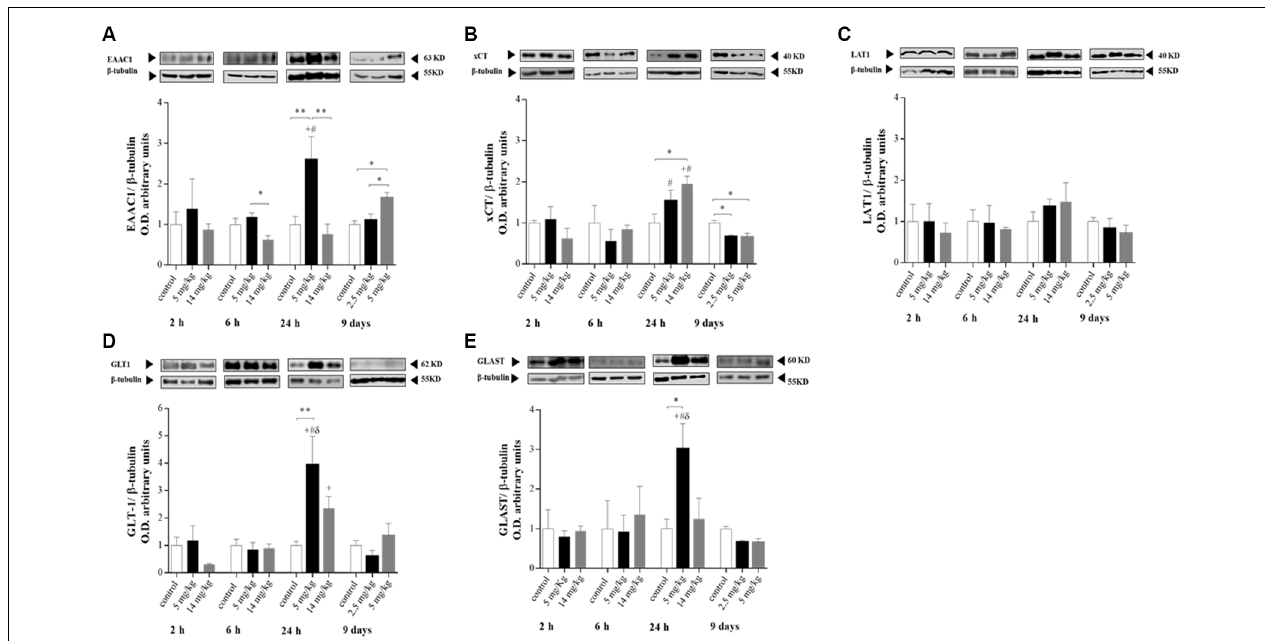
FIGURE 2 | Protein levels of the amino acid transporters excitatory amino acid transporter 3 (EAAT3; A ), xCT (B) , L-type amino acid transporter 1 (LAT1; C ), glial glutamate transporter 1 (GLT-1; D ), and glutamate/aspartate transporter (GLAST; E ) in the cortex of mice treated with 0, 2.5, 5, or 14 mg/kg NaAsO 2 . Changes in the protein levels in the enriched membrane fraction were evaluated by Western blot analysis at 2, 6, 24 h and 9 days after the last NaAsO 2 administration. Bars represent the densitometric analysis of the protein bands normalized to β -tubulin, mean ± SE, n = 6. The data were analyzed using one and two-way ANOVA with Tukey’s post hoc analysis. Different superscript symbols above each column indicate statistically significant differences; ∗ P ≤ 0.05, ∗∗ P ≤ 0.01 for dose-related differences; plus symbol denotes differences from the 2 h group, number symbol denotes differences from the 6 h group, and delta symbol denotes differences from 9 days group. Significance was accepted at P ≤ 0.05.